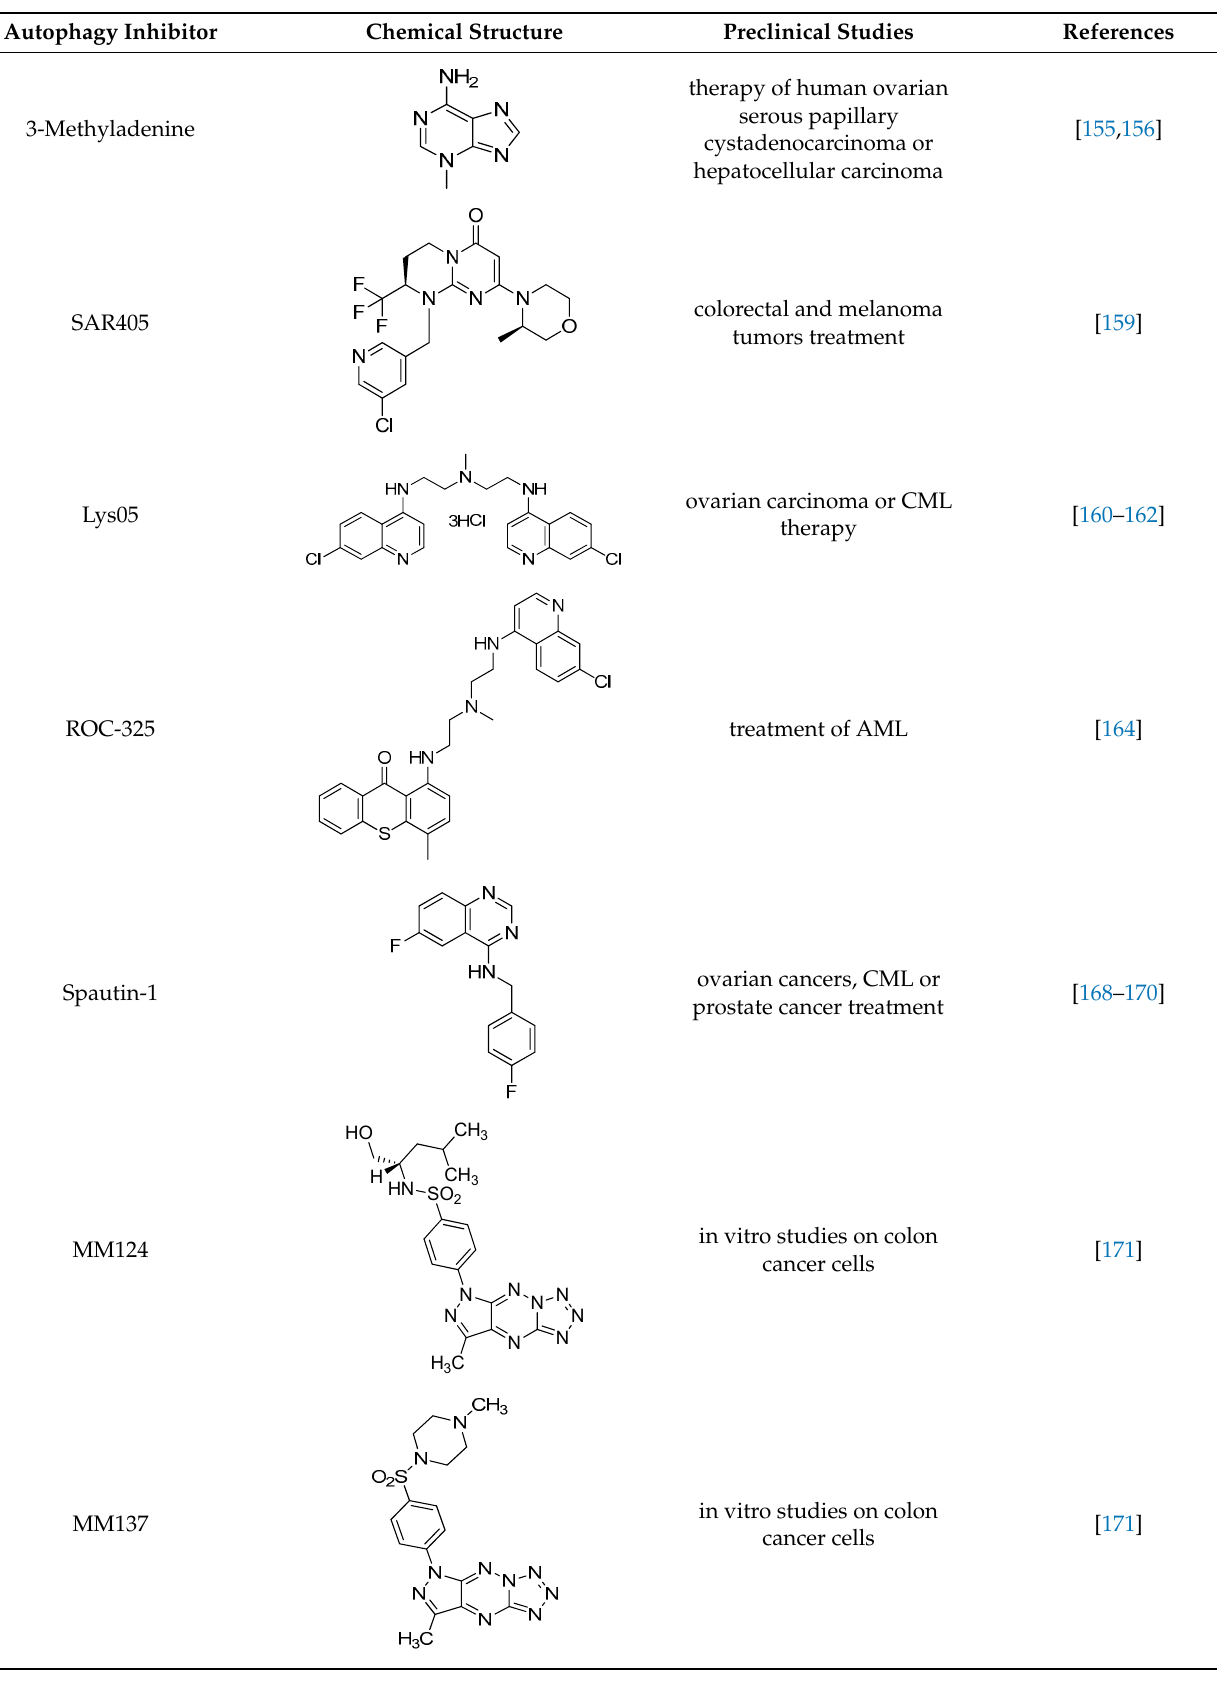
Table 3. Selected autophagy inhibitor under preclinical investigation.